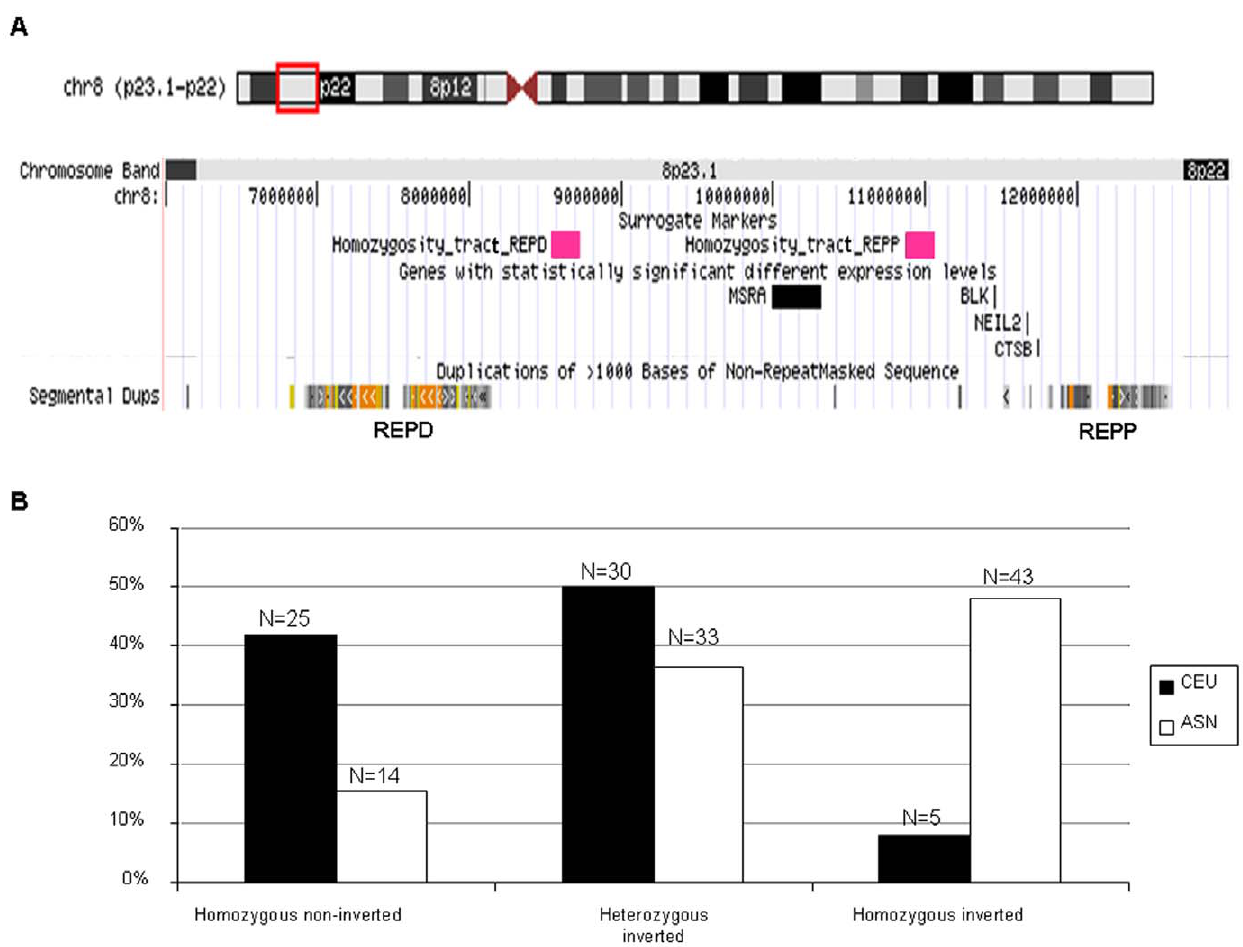
Figure 2. Scheme of the localization of the homozygosity tracts used as surrogate markers to predict the status of the human chromosome 8p23.1 inversion in HapMap samples (Homozygsity tract__REPD and Homozygosity tract__REPP). Genes differentially expressed on the association analysis and SDs are also depicted. B Frequencies predicted for the 8p23.1 inversion in CEU (white bars) and ASN (black bars) populations based on haplotypes for two blocks of 8 SNPs inside the region of the polymorphic inversion.